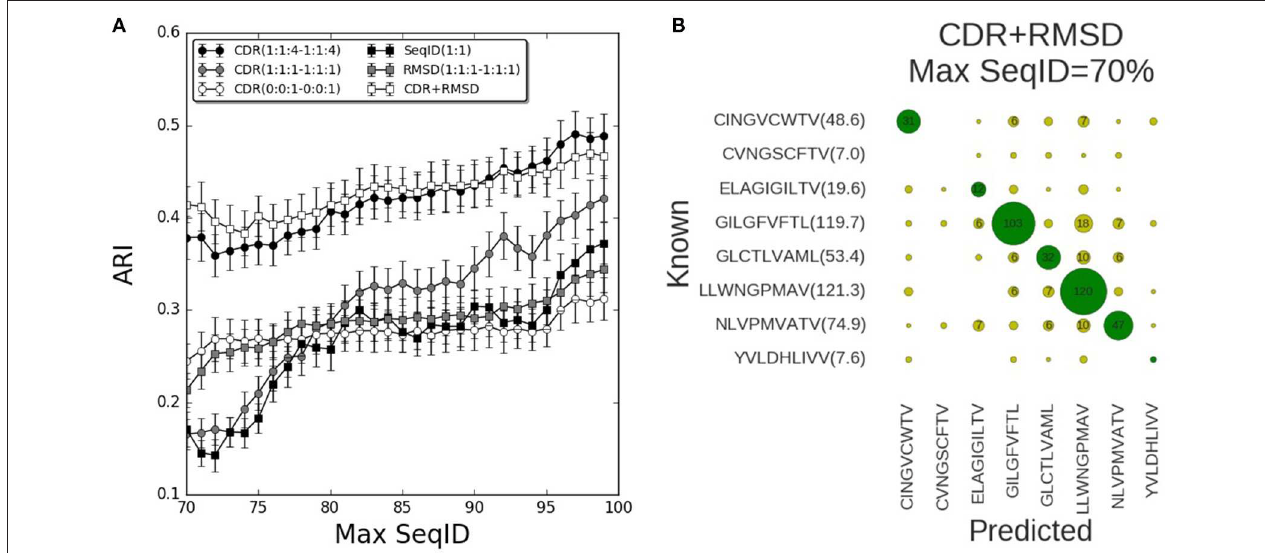
FIGURE 4 | Validation of pipeline performance on HLA (human) benchmark. (A) Prediction performance as a function of maximum sequence identity for different similarity models and relative weighting schemes. The combined model CDR + RMSD integrating structural similarities was made using W = 0.9 (see text). Error bars are estimated using bootstrap with 1,000 iterations on the final prediction outcome. (B) Confusion matrix for the CDR + RMSD model at a Max SeqID threshold of 70% (with an ARI of 0.41). Green circles are correctly predicted peptides and yellow circles represent wrong peptide predictions. Numbers lower than 5 are omitted for clarity. In parentheses is displayed the average number of TCRs that bind the same peptide and remain after removing entries with Max SeqID >